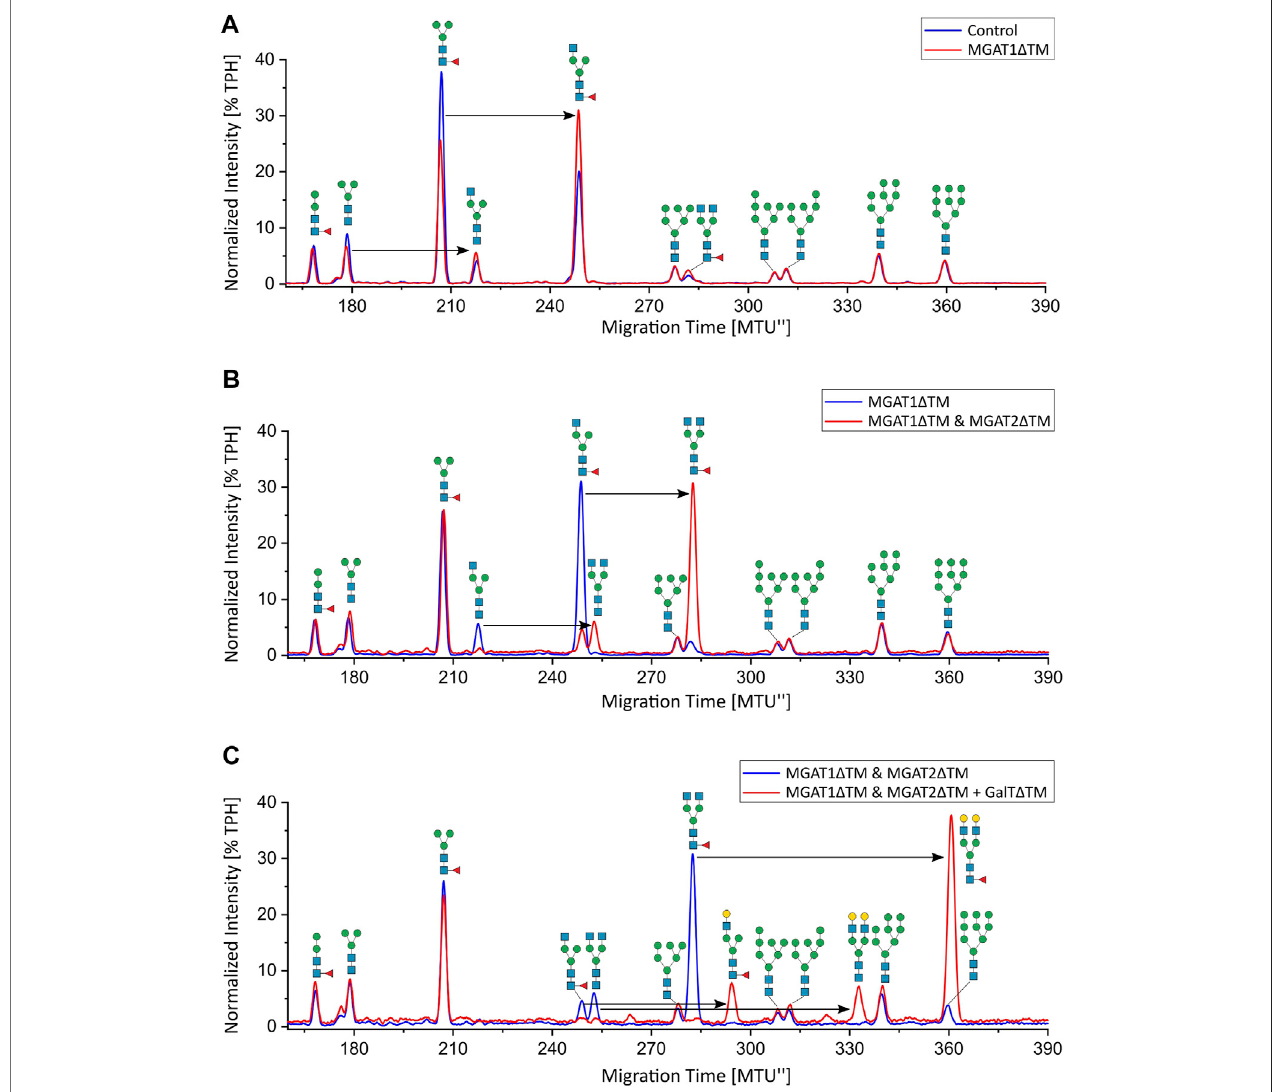
FIGURE 2 | xCGE-LIF N -glycan fi ngerprints of unprocessed and in-vitro glycoengineered SARS-CoV-2 spike protein N -glycans. N -glycosylation pattern of the spike protein: (A) unprocessed (blue) and 12 h after start of the reaction with MGAT1 Δ TM (red); (B) 12 h after start of the reaction with MGAT1 Δ TM (blue) and 12 h after the addition of MGAT2 Δ TM (red); (C) 12 h after the addition of MGAT2 Δ TM (blue) and 12 h after addition of GalT Δ TM (red). TPH, total peak